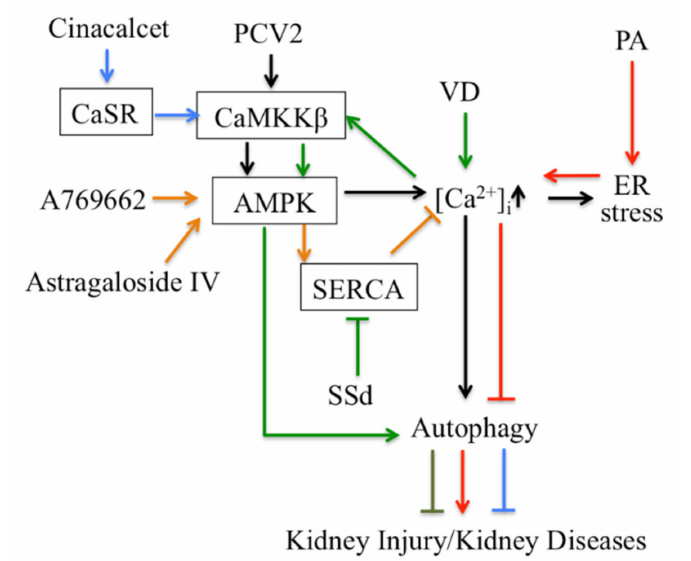
Figure 2. Targeting autophagy regulated by Ca 2+ signaling for therapy in kidney disease. CaSR: Calcium sensing receptor; PA: Palmitic acid; PCV2: Porcine Circovirus Type 2; SSd: Saikosaponin-d; VD: vitamin